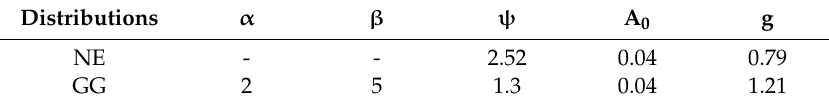
Table 1. Values of turbulence and pointing errors